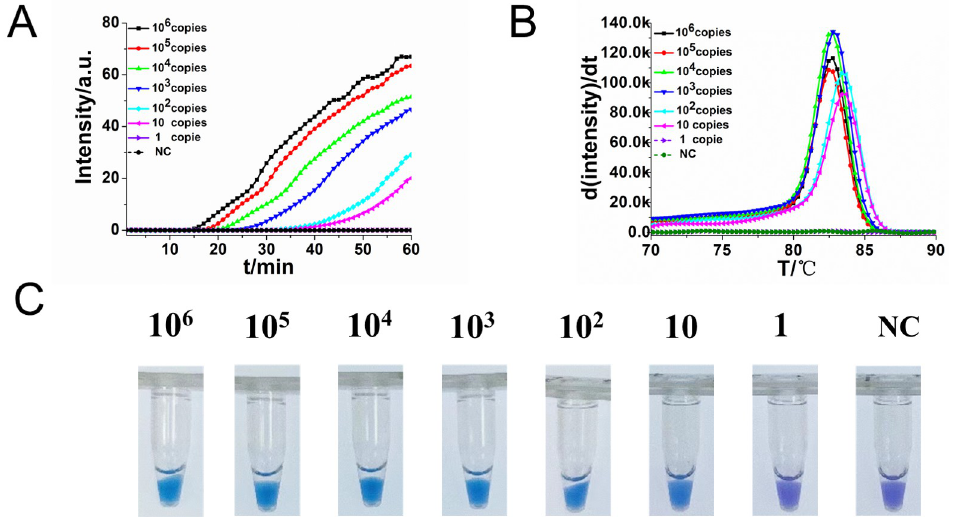
Fig 4. Sensitivity analysis of the R . raoultii RO-CDA method by real-time and visual approaches. (A) RO-CDA amplification monitored by real-time PCR every 1 min at different concentrations of DNA. Reaction was performed at 60˚C for 60 min. (B) Melting curve analysis of RO-CDA products at different concentrations of DNA. (C) Sensitivity analysis of R . raoultii detection by visually RO-CDA. The DNA concentrations were as follows: 10 6 copies/ μ L, 10 5 copies/ μ L, 10 4 copies/ μ L, 10 3 copies/ μ L, 10 2 copies/ μ L, 10 copies/ μ L, 1 copy/ μ L and negative control (nuclease-free water). NC, negative control reaction without the